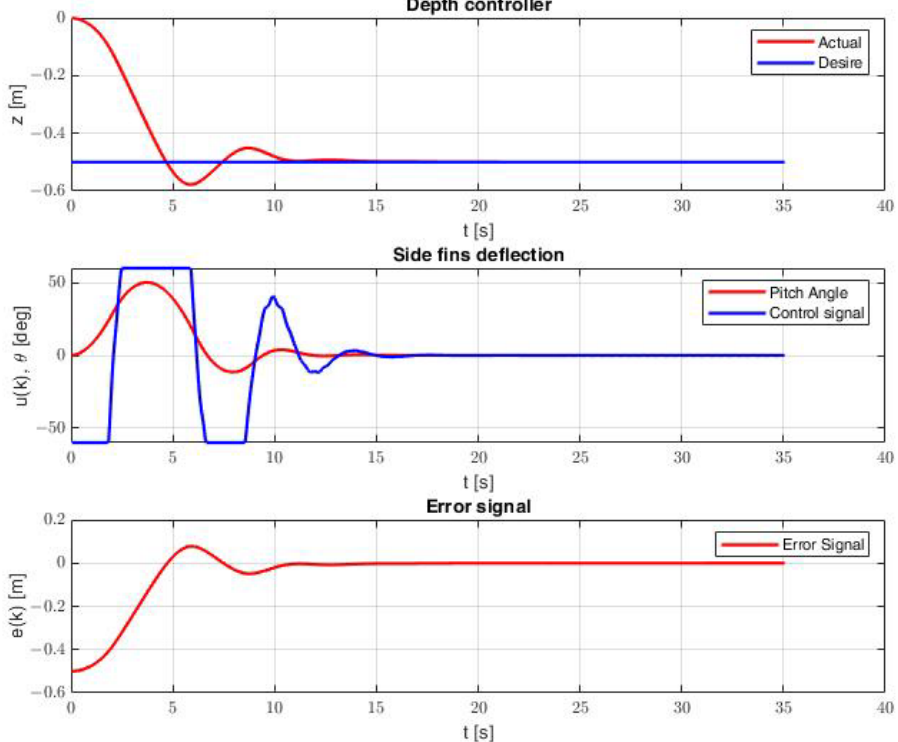
Figure 6. Changes of immersion and side fins deflection in time in response to desired depth: 0.5 [m] obtained for PID controller settings using GA method and fitness function no. 3 for two depth